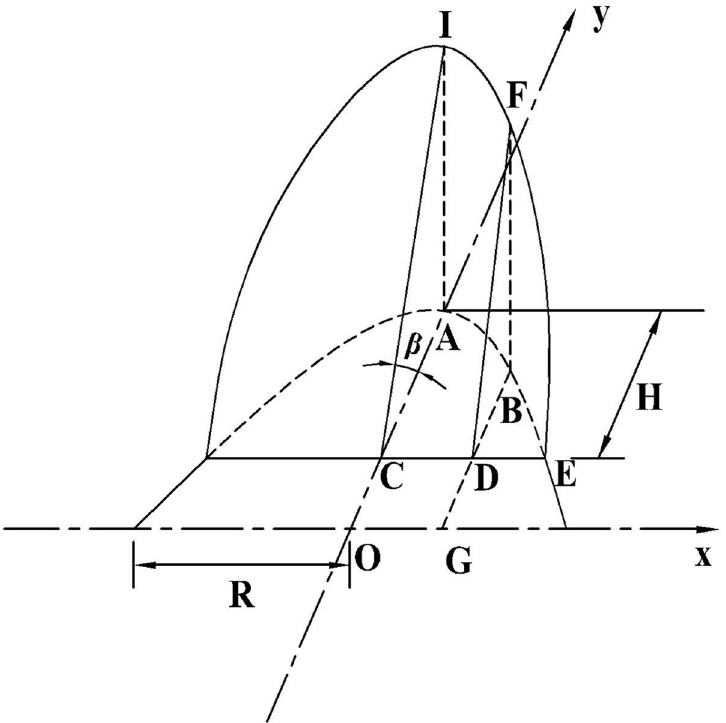
Fig 2. Geometric diagram of a scalene cylinder cut by cross section.